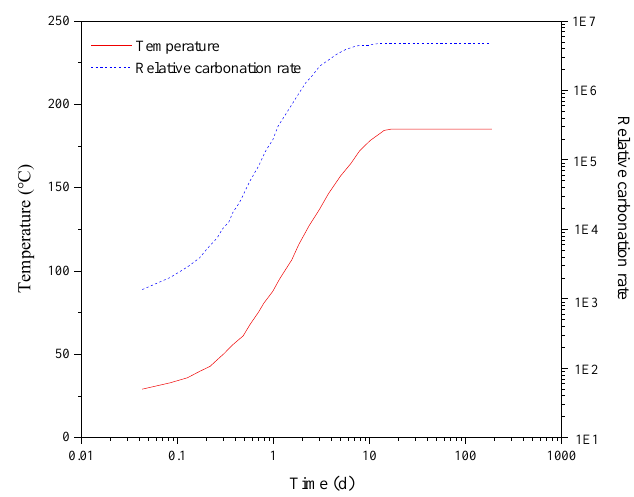
Figure 10. Calculated temperature and the carbonation rate relative to the rate for CO 2 in surface water at 25 °C and 0.1 MPa in the three-step injection operation (adapted from [181]).